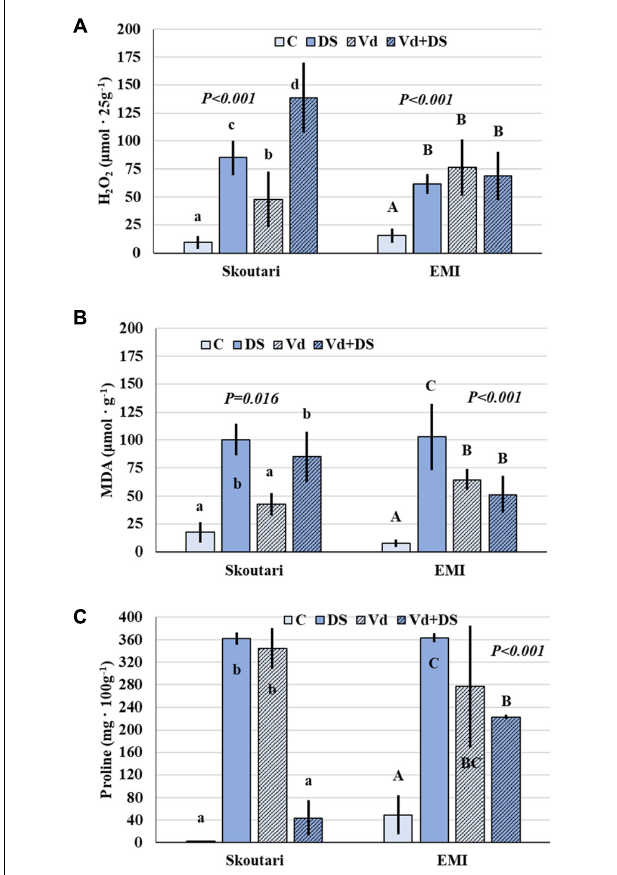
FIGURE 3 | H 2 O 2 , MDA, and Proline concentration alterations in eggplant cultivars subjected to abiotic, biotic and combined stresses. The H 2 O 2 , MDA, and Proline concentration ( A–C , respectively) were measured in eggplant cultivars under individual and combined stress. C, control, DS, drought stress, Vd, Verticillium dahliae , Vd+DS, Combined stress. Bars represent standard deviation. Means within the same cultivar with different lower (Skoutari) or upper (EMI)-case letters are significantly different according to Student Newman Keuls test ( P <